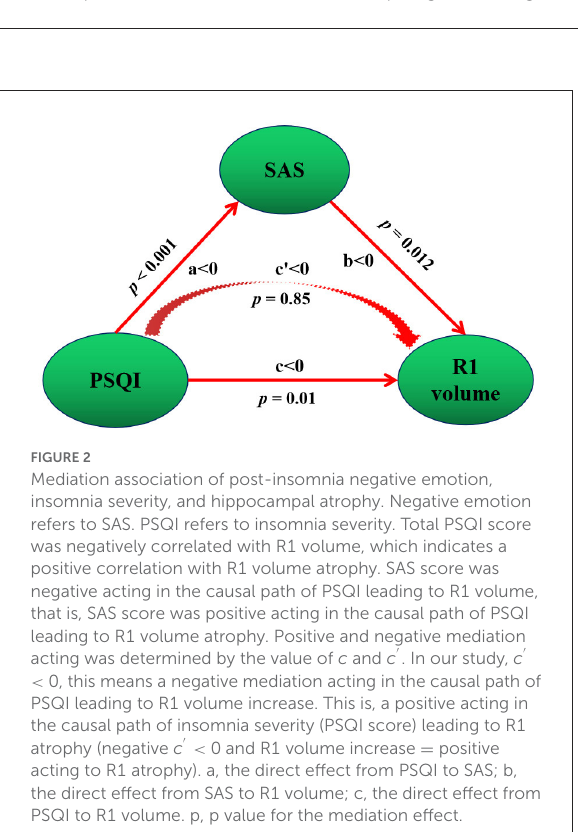
FIGURE1 Visual competing risk-nomogram tool for individual prediction of insomnia. The TrackPoint shows an example of one subject for his/her point score and corresponding risk of development of insomnia. For this subject, his/her total point score is 496, and the corresponding risk of development of insomnia is 83.21%. (A) Competing-risk nomogram; (B) Agreement calibration curve.